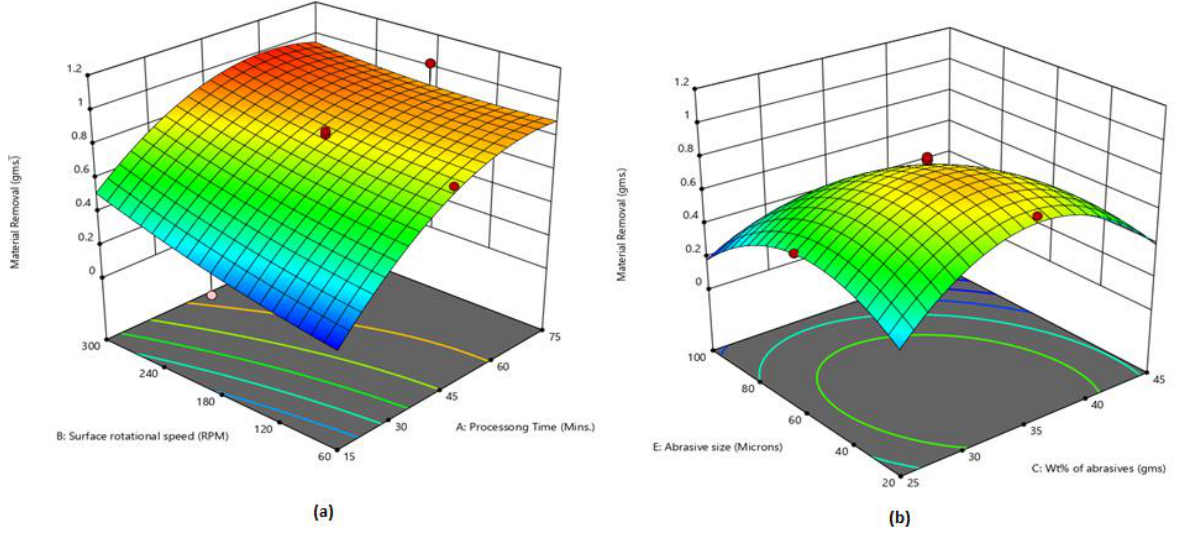
Figure 6. ( a ) Influence of processing time and rotational speed on MR; ( b ) influence of wt% of abrasives and abrasive size on MR.